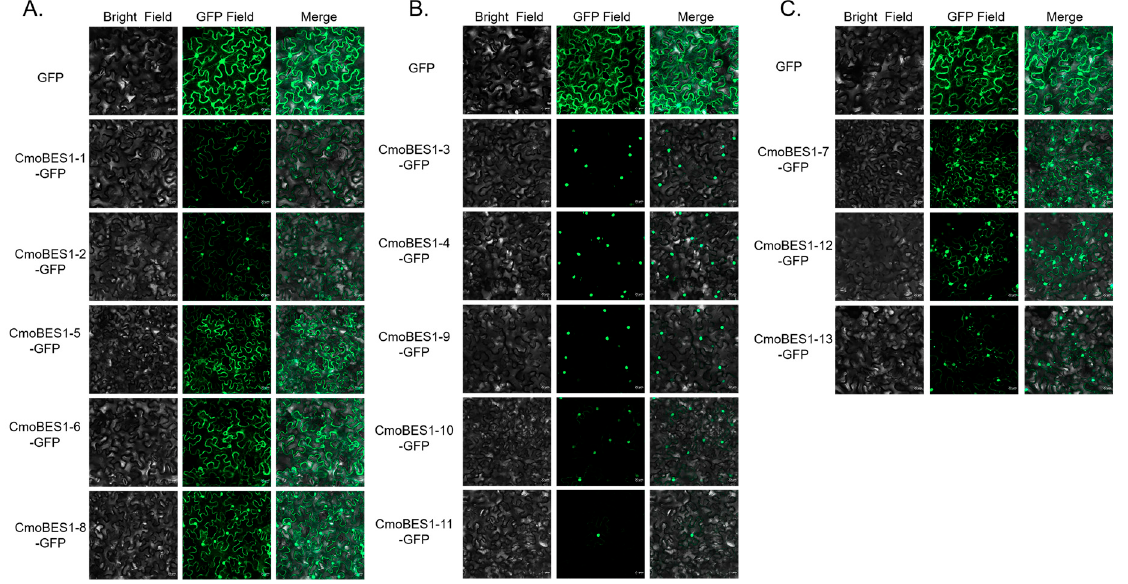
Figure 6. Subcellular localization of CmoBES1 proteins in Nicotiana benthamiana leaves. ( A ) CmoBES1-1, -2, -5, -6, -8-GFP proteins; ( B ) CmoBES1-3, -4, -9, -10, -11-GFP proteins; and ( C ) CmoBES1-7, -12, -13-GFP proteins. Each line contains a bright field, GFP field, and merged photos, and the empty GFP was the control. The length of the scale bar is 20 μ m.